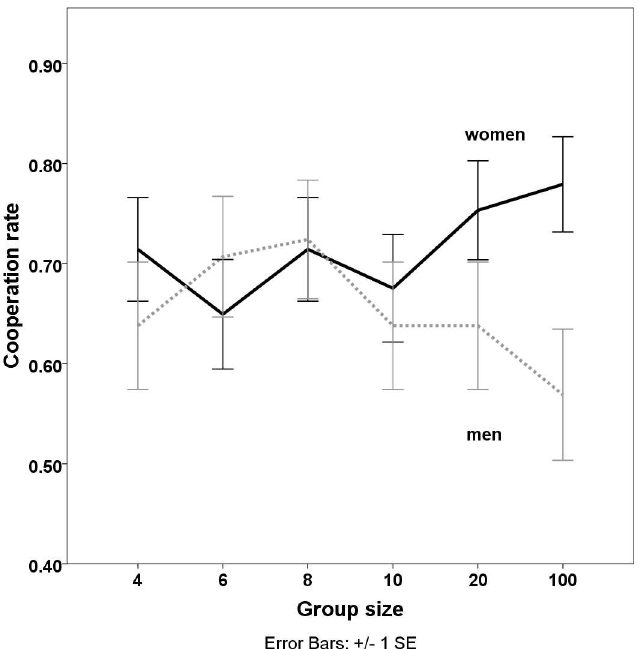
Fig 3. Cooperation rate of men and women as a function of group size. To control for risk aversion , age , and personality ( extraversion , agreeableness , conscientiousness , neuroticism , openness , and locus of control ) we ran several randomeffects logistic regressions. The descriptivestatistics for the control variables are summarized in Table 2. Correlations of the independent variablescan be found in Table 3. Results of the regression analysesare reportedin Table 4.